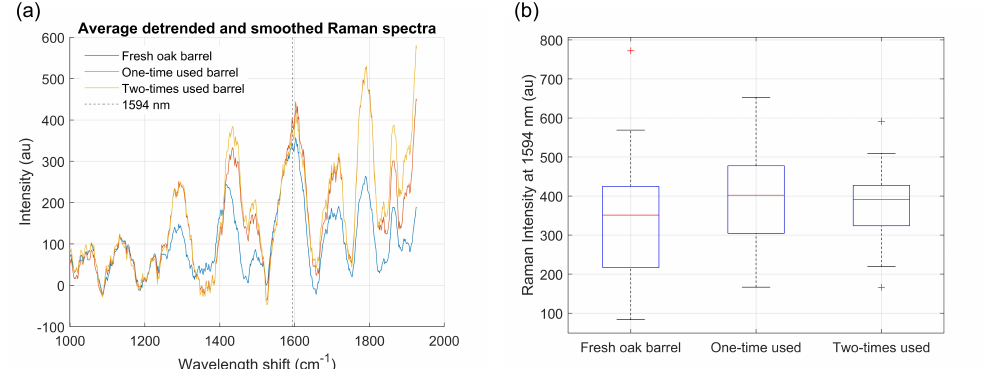
Figure 6. ( a ) Average detrended and smoothed Raman signals of the three oak samples. ( b ) Box-plot of the Raman signal at 1594 nm, which is the characteristic tannin peak. Large variability is present due to the localized measurement technique, influenced by the inhomogeneous wood itself, showing that the different classes are inherently not